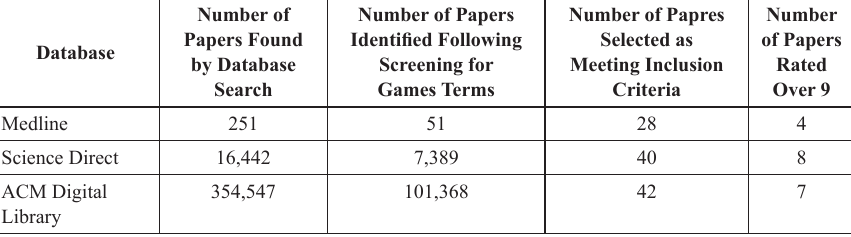
Table 1. Total number of papers identified from each database, identified following screening, selected as meeting inclusion criteria and quality coded over 9 Number of Number of Papers Number of Papres Number Papers Found Identified Following Selected as of Papers Database by Database Screening for Meeting Inclusion Rated Search Games Terms Criteria Over 9 Medline 251 51 28 4 Science Direct 16,442 7,389 ACM Digital Library